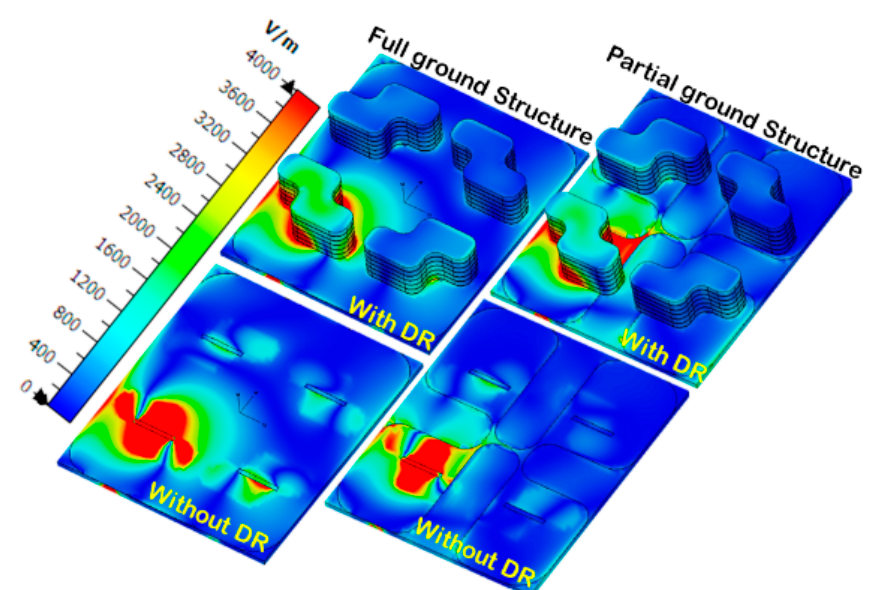
Figure 10. E-field distribution in four-port antenna with full and partial ground structure at 9.53 GHz.